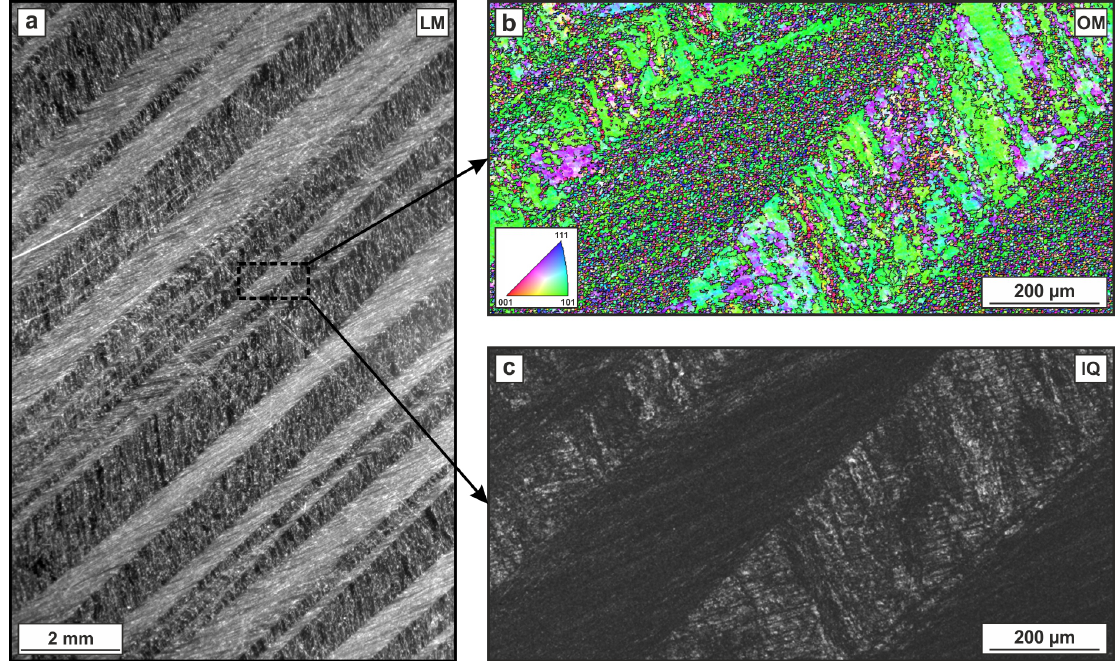
Figure 13. Microstructure after heterogeneous deformation by one pass of ECAP of a severely cold worked conventional 6000 series aluminum alloy. Optical micrograph ( a ) showing a microstructural overview and color-coded orientation map OM ( b ) and image quality map IQ ( c ) from EBSD